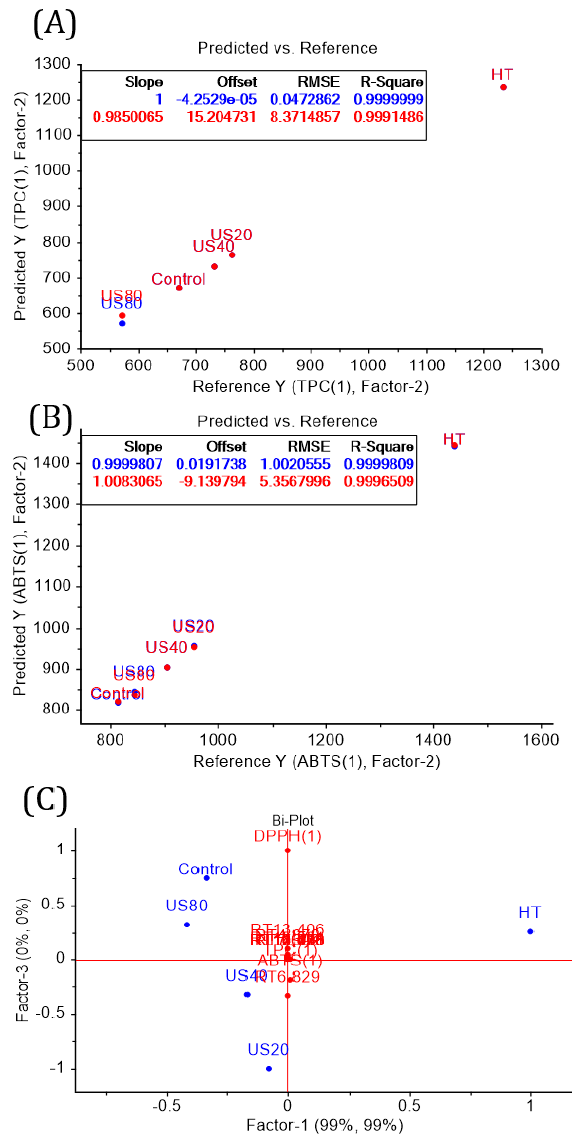
Figure 3. Partial Least Squares (Mean centered) of Amazon fig juice. ( A ) and ( B ) represents the model response as a function of TPC and ABTS; ( C ) is the result of loadings (chemical composition and antioxidant result) and score (sample group) Bi-plot. Algorithm used: Kernel; Validation method: Cross validation. Full with 5 segments. Number of calibration samples used: 5; total number of factors: 3; factors suggested by model: 2; optimal number of factors: 2.